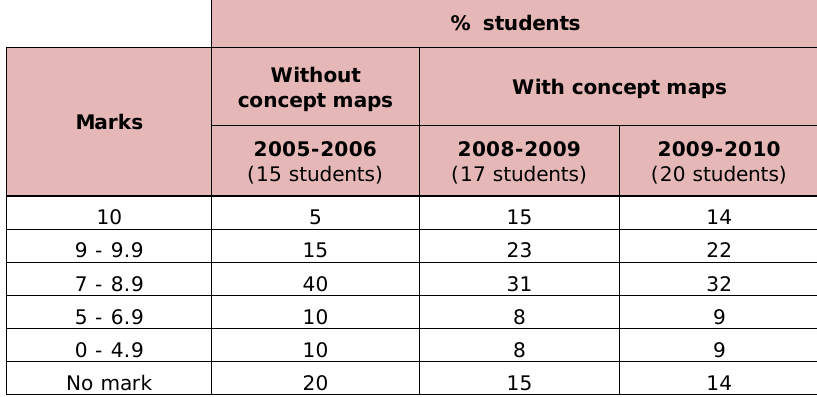
Table 1. “Final marks of the subject Chemical Processes